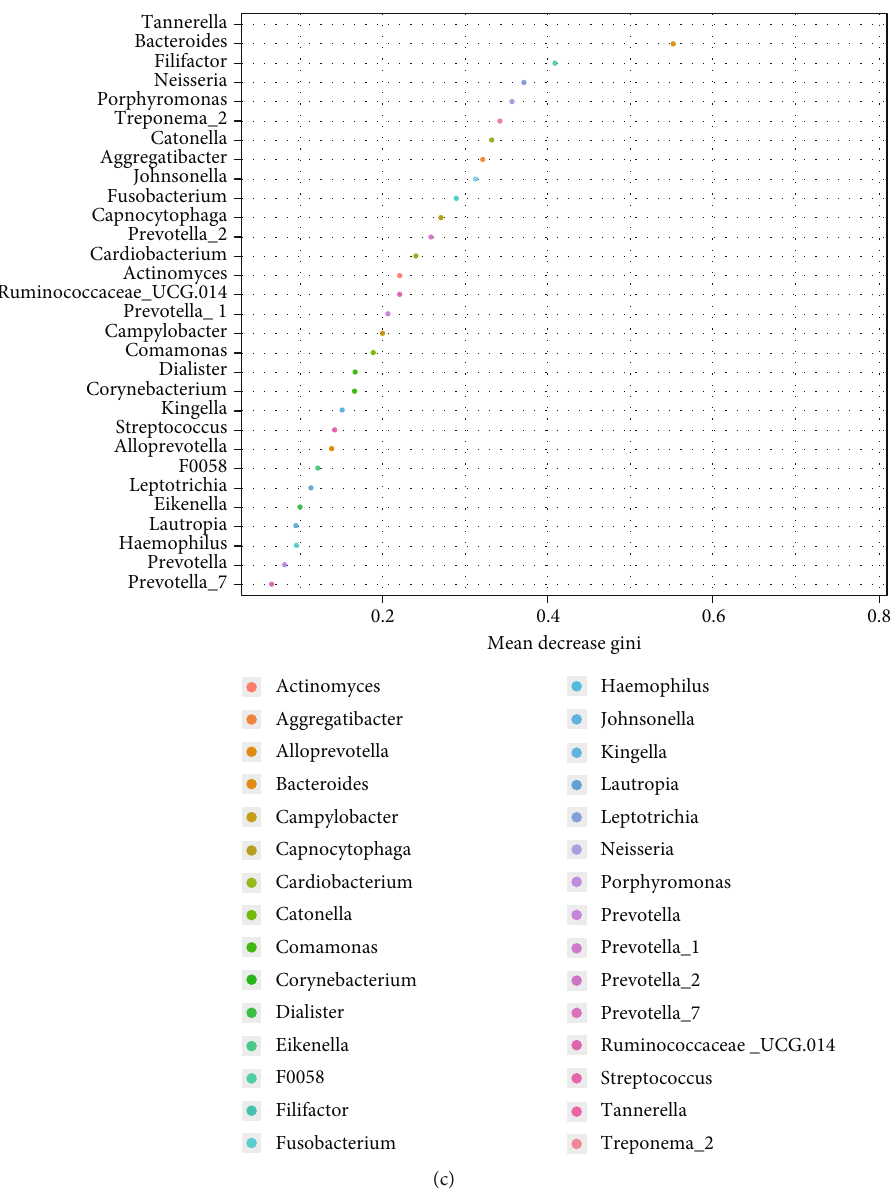
Figure 5: Linear discriminant analysis (LDA) e ff ect size (LEfSe) analysis of the oral microbiomes in young male and female patients with severe and advanced periodontitis. (a) Histogram of the LDA scores of males and females. Female-enriched taxa are indicated by a positive LDA score (green), and taxa enriched in males have a negative score (red). (b) Taxonomic cladogram obtained from LEfSe analysis. Red indicates male, green indicates female, and yellow indicates nonsigni fi cant between males and females. (c) Point map of species importance. The horizontal axis is the measure of importance, and the vertical axis is the name of the species sorted by